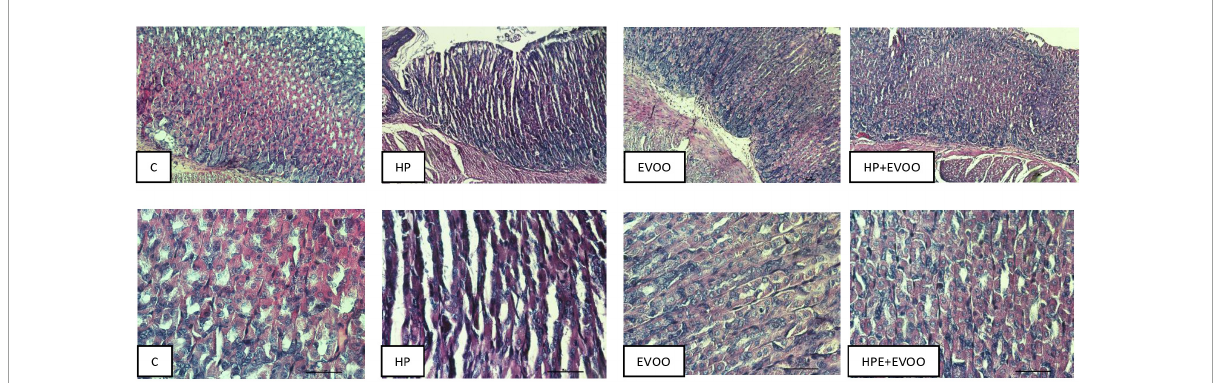
FIGURE6 Hematoxylin–Eosin stain at 7 days after infection. The mucosa of the control and extra virgin olive oil (EVOO) groups shows normal histological characteristics. The mucosa of animals infected with Helicobacter pylori shows apparent injuries, mainly disruptions of the lining epithelium and damage in the isthmus and the neck of gastric glands. A decrease in the size of the gland epithelial cells can be observed. Blood, remnants of injured tissue, and some mucus filaments are observed in the lumen. The mucosa of animals infected with H. pylori and treated with EVOO shows morphological characteristics similar to those of normal and EVOO mucosa, even though slight damage is observed. Scale bar: 40 µ